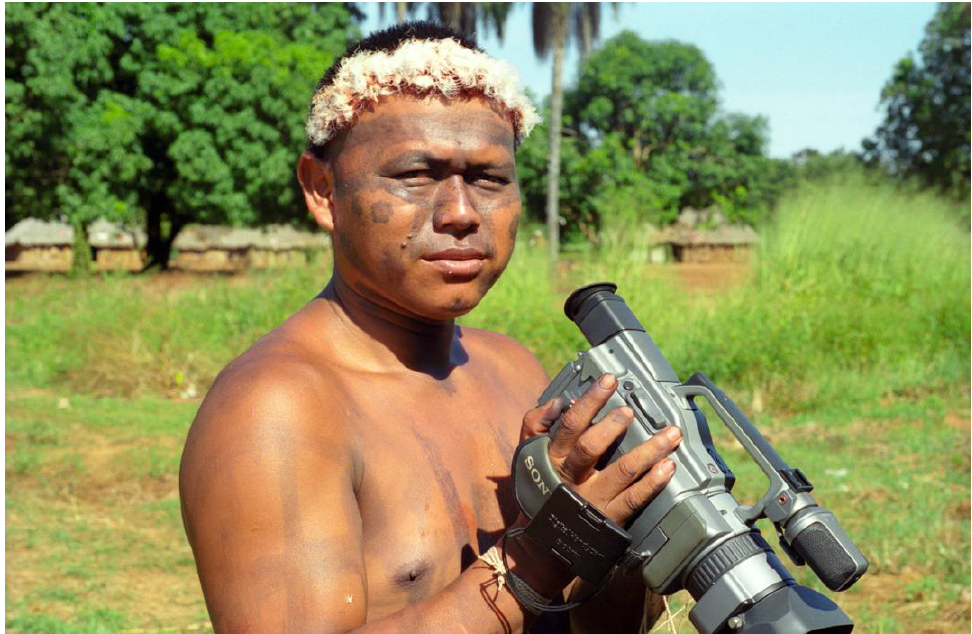
Figure 5 . Waiassé filming in full ceremonial regalia. Source: Photo courtesy of Rosa Gauditano/Studio R